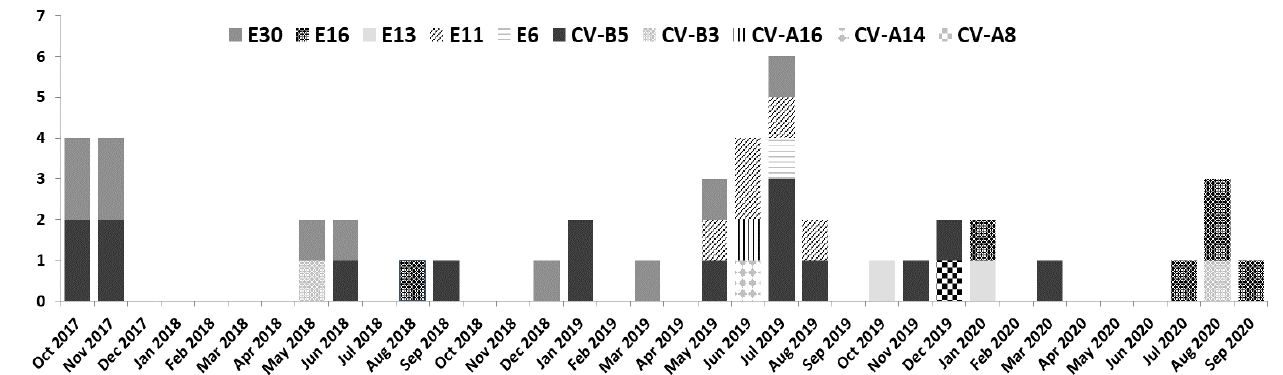
Figure 2. Seasonal and annual distribution of the 10 enterovirus (EV) genotypes detected in 45 children with EV CNS